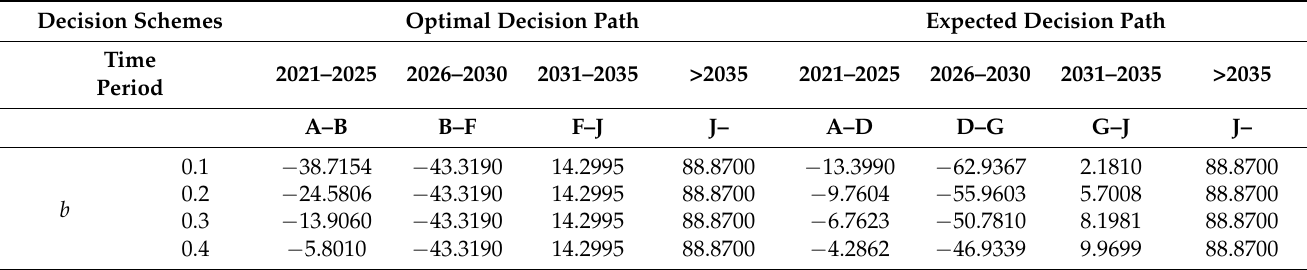
Table 5. Investment decision result of Qingdao Port ARMGs’ low-carbon transition under the change of technology